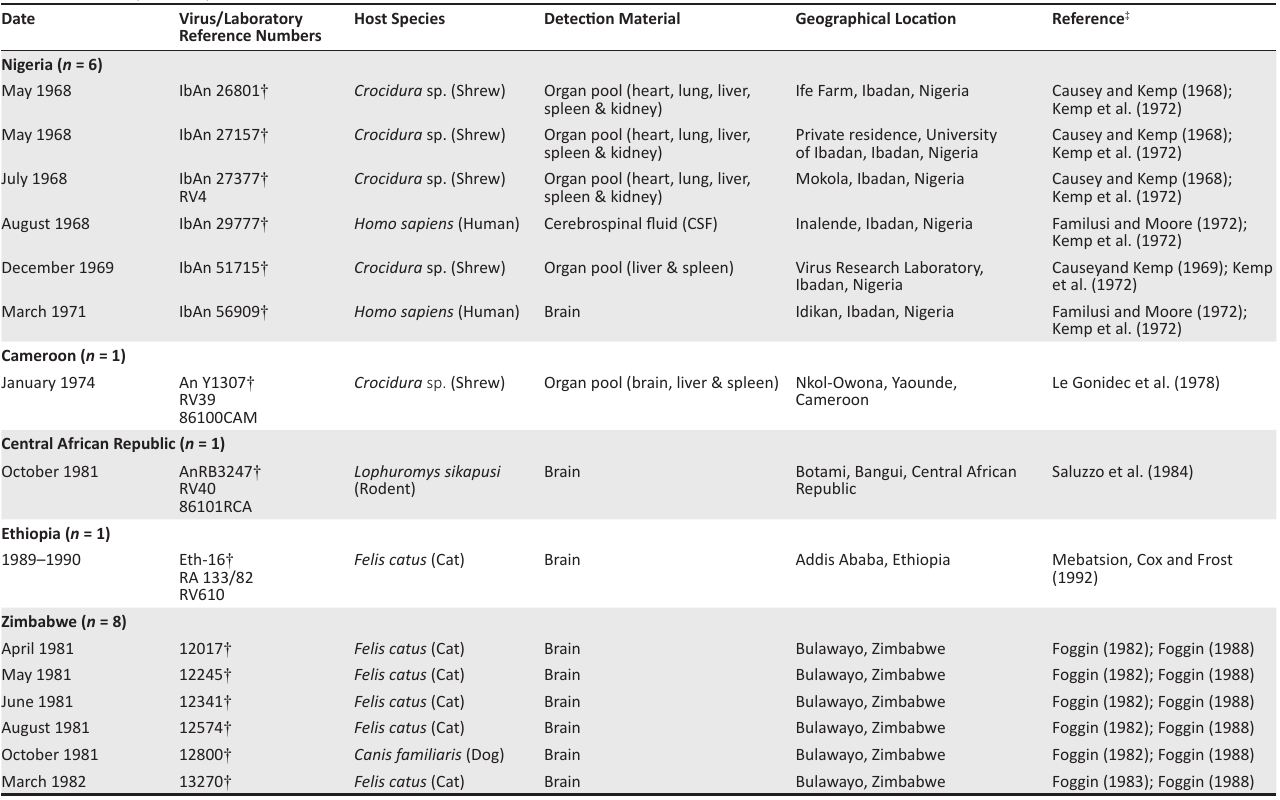
TABLE 1: Summary of all reported Mokola virus cases in